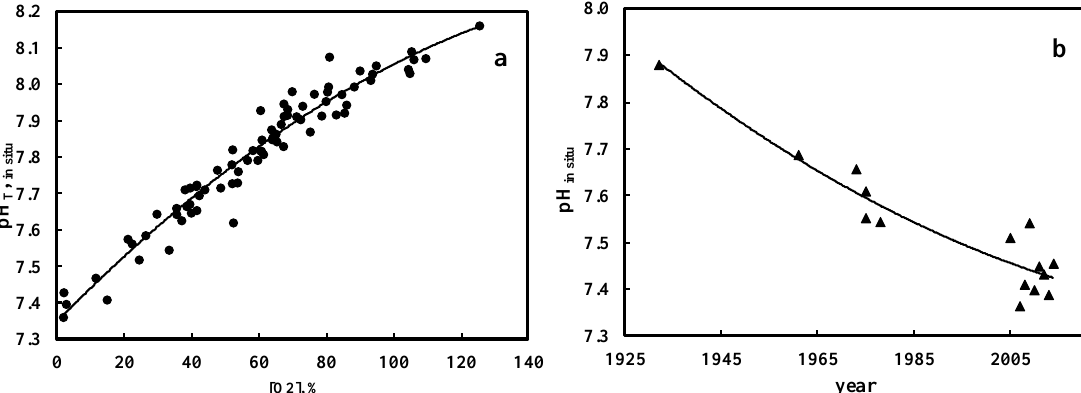
Figure 5. Dependence of ( a ) pH T (in situ) vs. DO saturation degree; ( b ) interannual variability of pH in situ values in the bottom waters of Amursky Bay in summer, predicted by Equation (1).